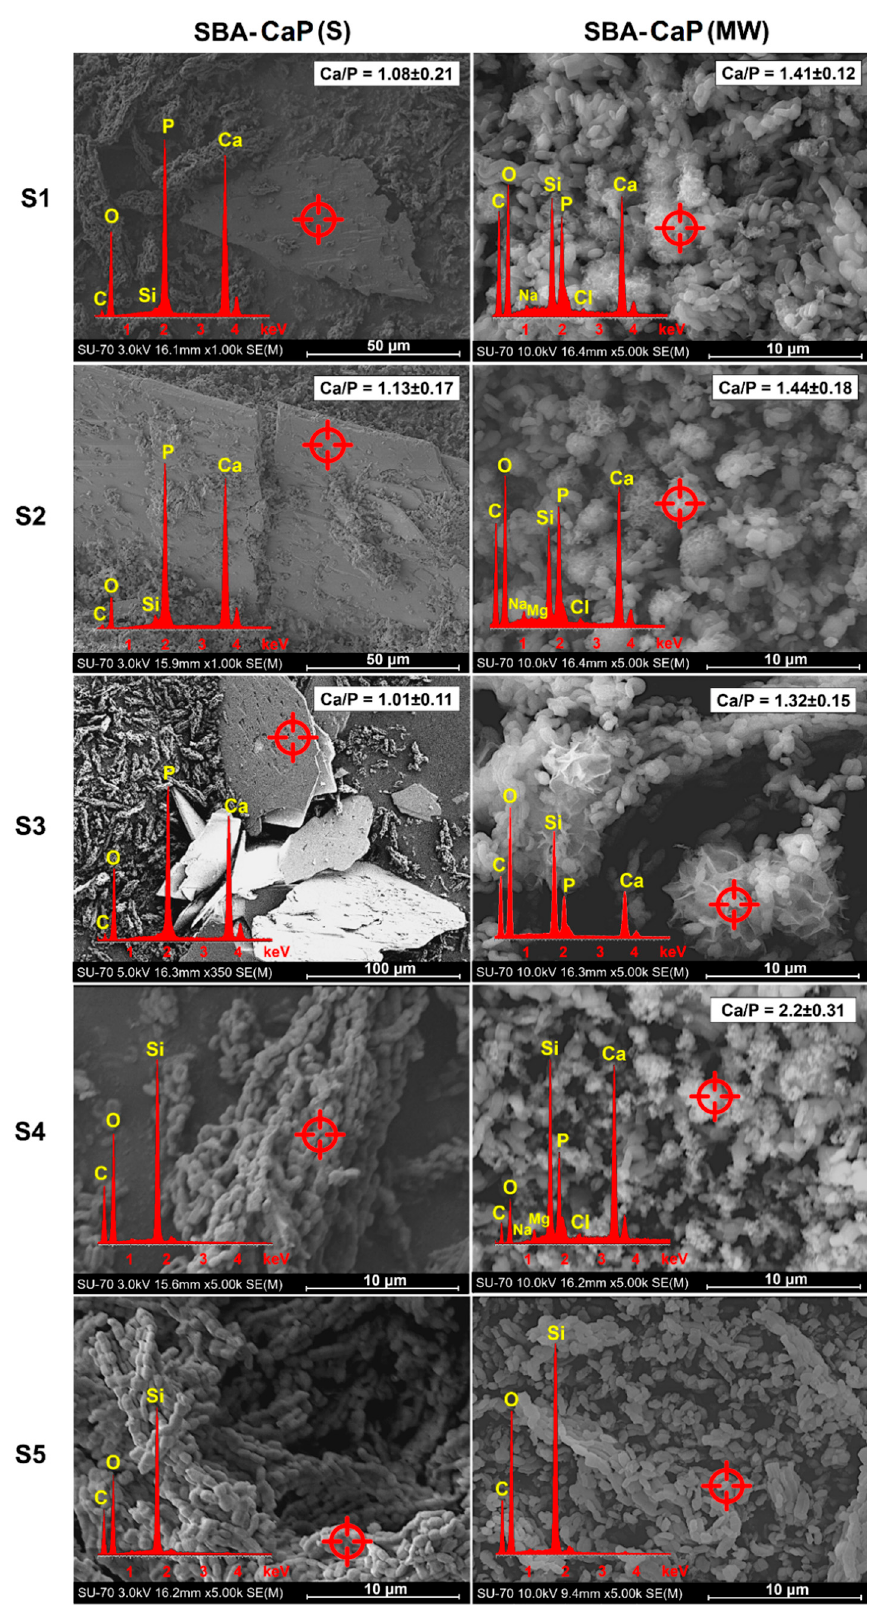
Figure 1. SEM-EDX micrographs of silica-calcium phosphate composites obtained using standard (SBA-CaP(S)) and microwave-assisted (SBA-CaP(MW)) rapid coating procedures with ( S1 – S5 ) coating solutions.